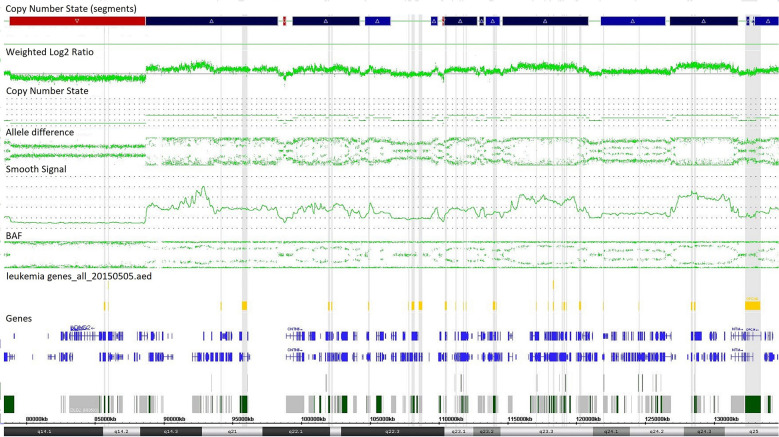
Complex copy number gains and losses in region 11q14.1q25 of chromosome 11 in patient with T-cell ALL by single-nucleotide polymorphism (SNP) array (case z219-401). Colored segmental regions (top line: red color—deletions; blue color—gains), copy number state allele difference, and smooth signal (bottom panel) aberrations by SNP array.